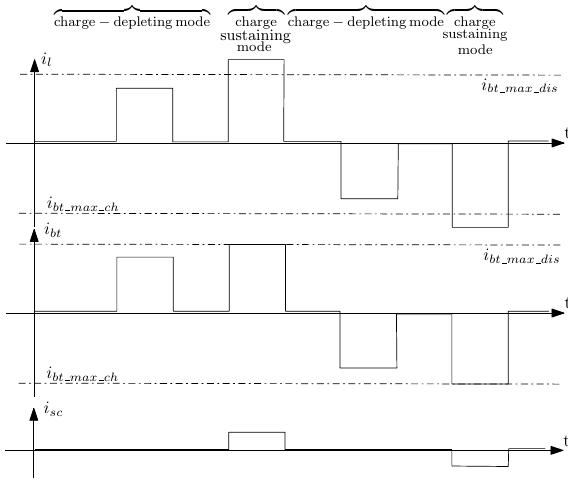
Figure 4. Charge-depleting and Charge-sustaining